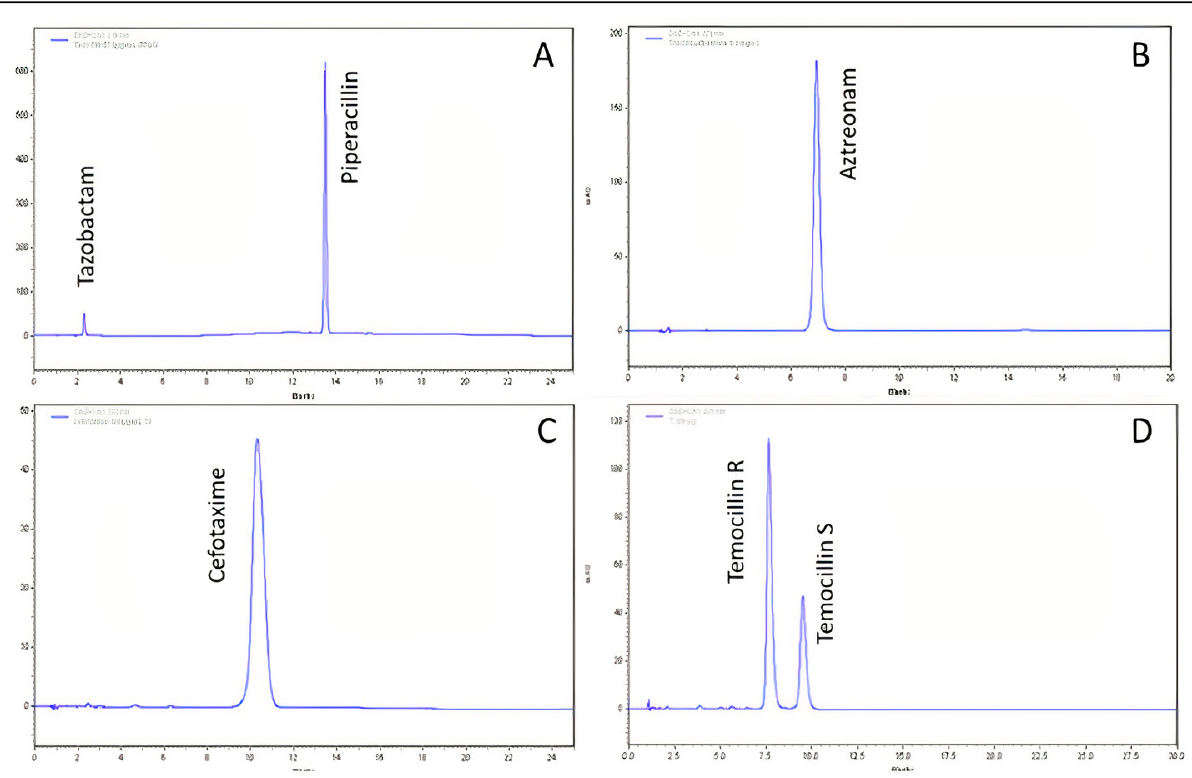
Figure 1. Examples of chromatograms of piperacillin/tazobactam (300/37.5 µg/mL) ( A ); aztreonam (100 µg/mL) ( B ); cefotaxime (100 µg/mL) ( C ); and temocillin R and S (150 µg/mL) ( D ), obtained immediately after reconstitution in Normal Saline